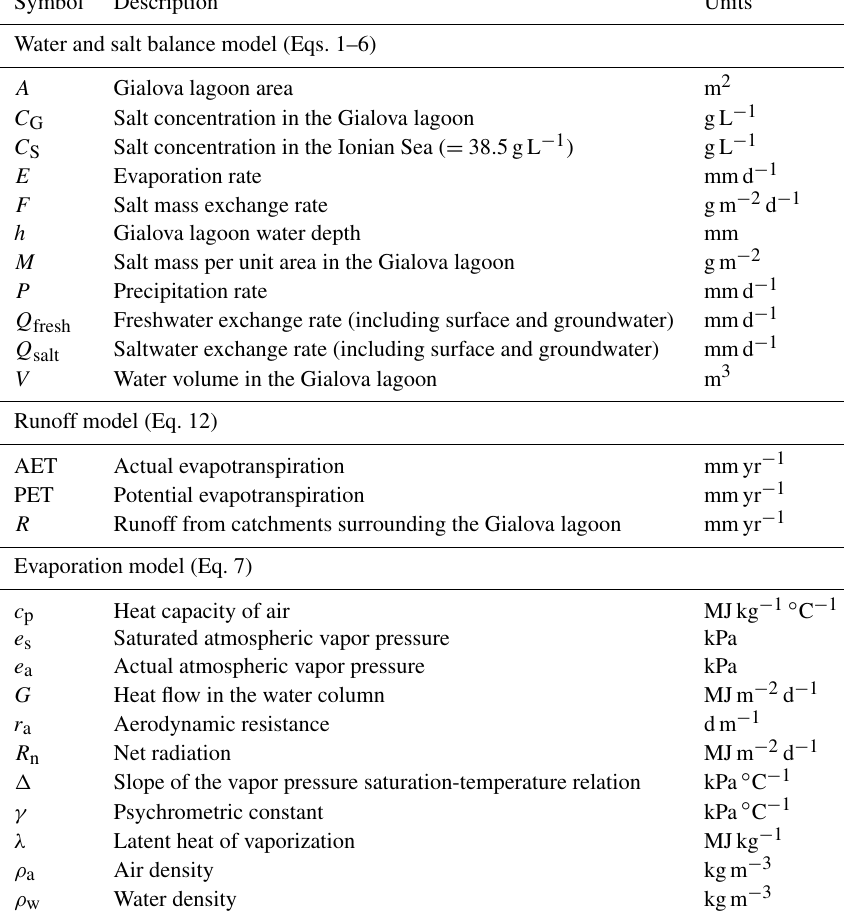
Table 1. Definition of symbols used in the mass balance model and in the calculation of the evapotranspiration rate. Symbol Description Units Water and salt balance model (Eqs. 1–6) A Gialova lagoon area m 2 C G Salt concentration in the Gialova